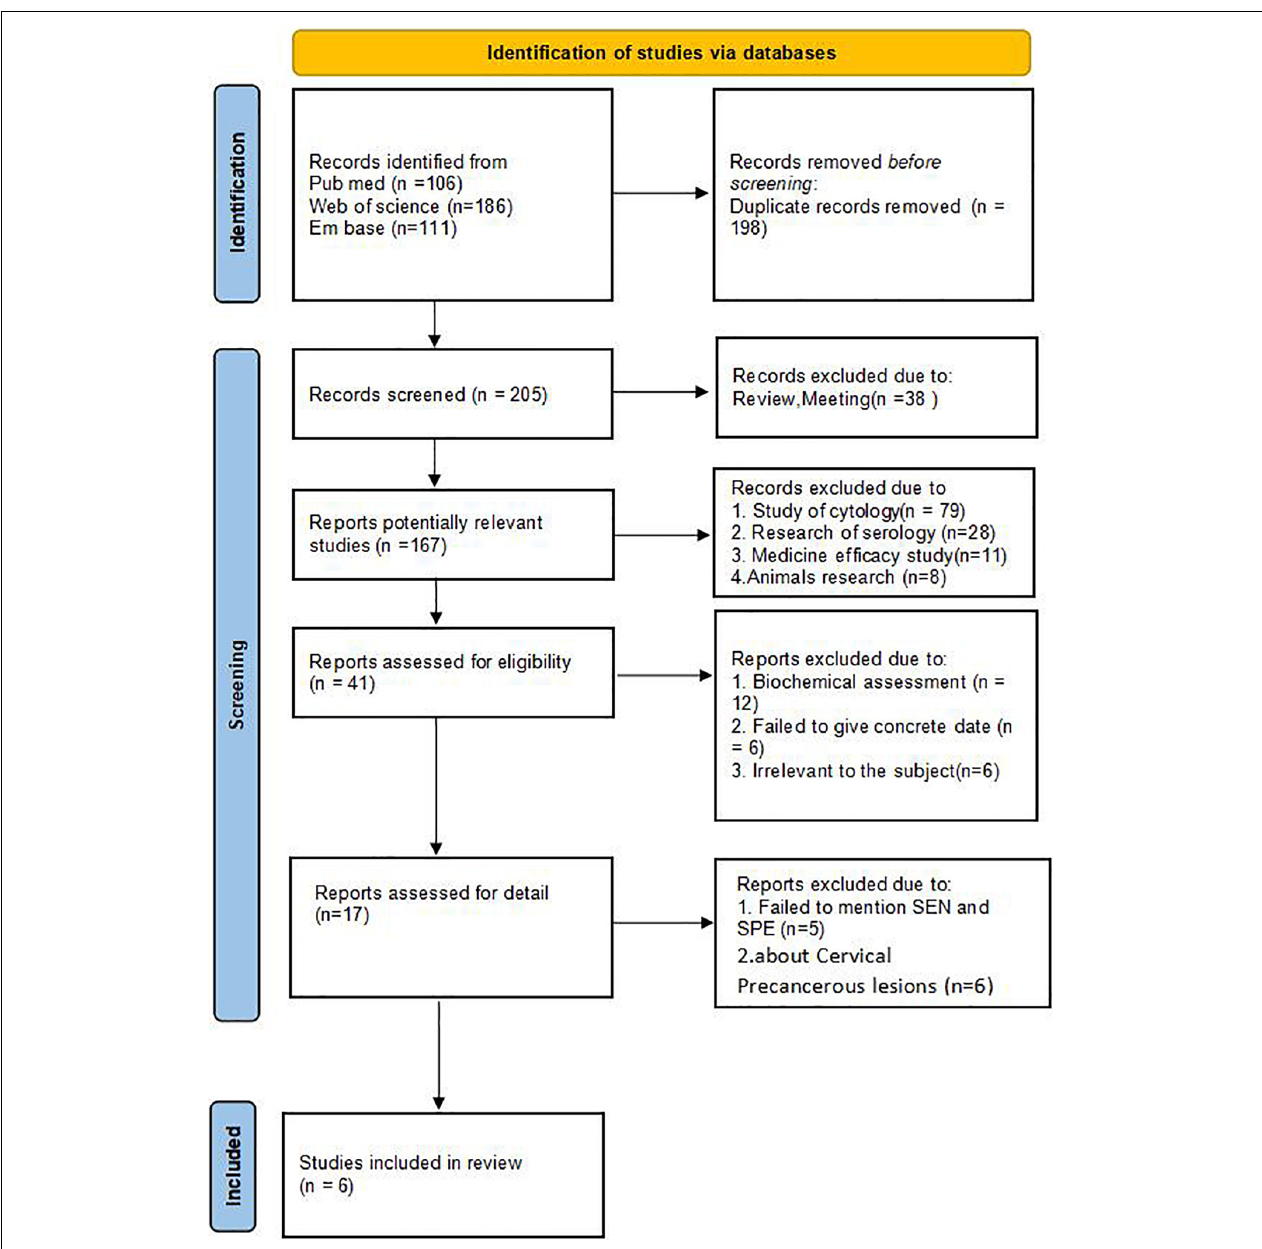
FIGURE 2 | PRISMA 2020 flow